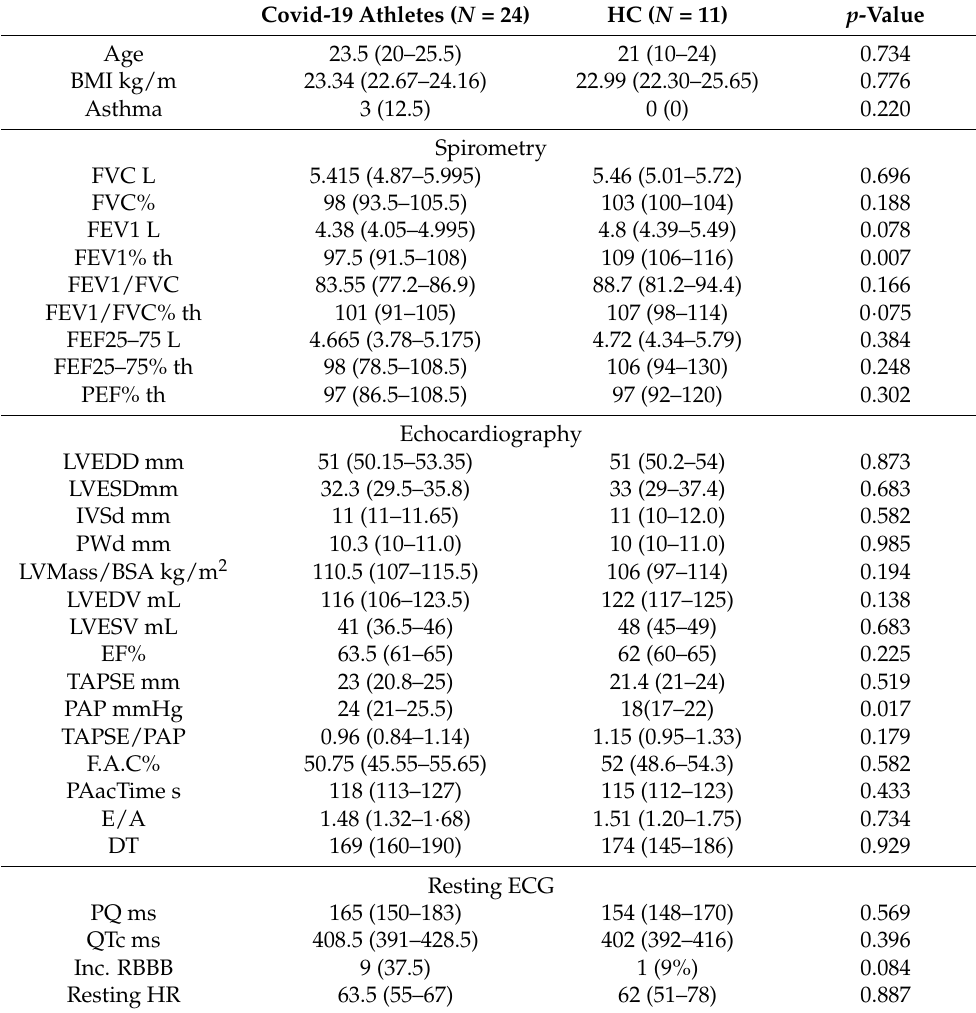
Table 3. Comparison between COVID-19 athletes and Healthy